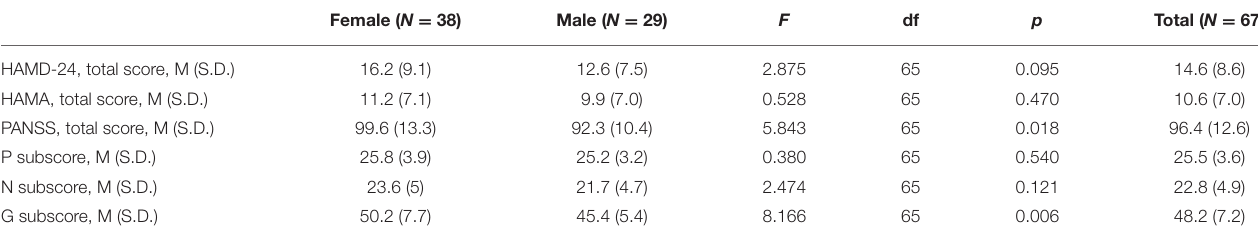
TABLE 2 | Mean baseline psycho-pathological scores for patients (Chengdu, China, 2018) by sex. Female ( N = 38) Male ( N = 29) F df p Total ( N = 67) HAMD-24, total score, M (S.D.) HAMA, total score, M